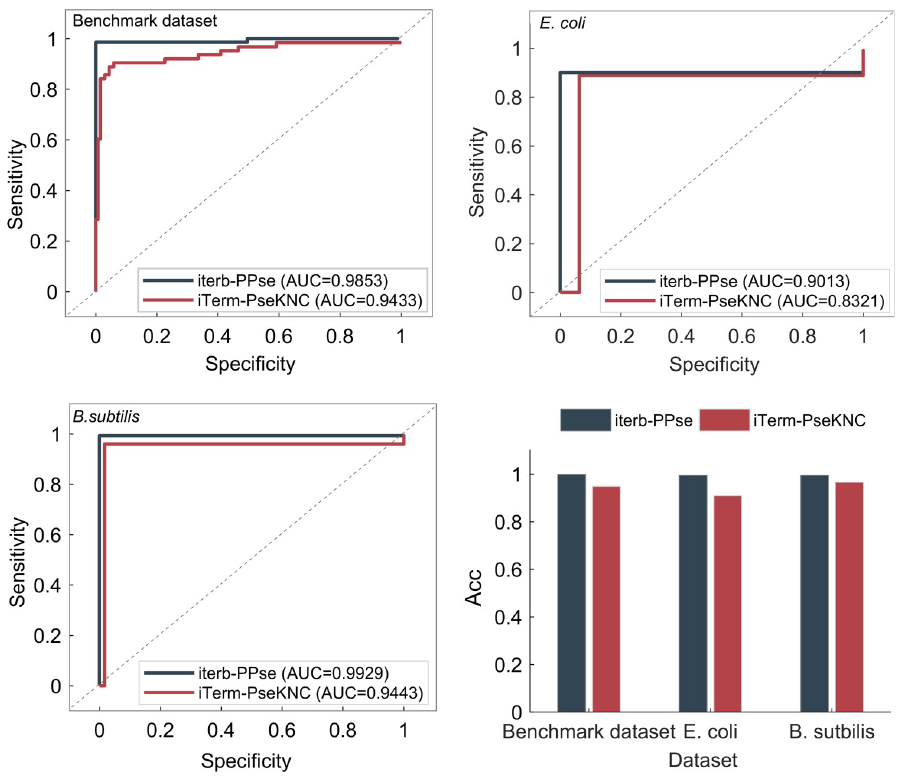
Fig 7. Comparison of “iTerm-PseKNC” and “iterb-PPse”. (A)-(C) ROC curves of two methods’ performance on the benchmark dataset and independent sets. (D) Prediction accuracy of two methods on different datasets.